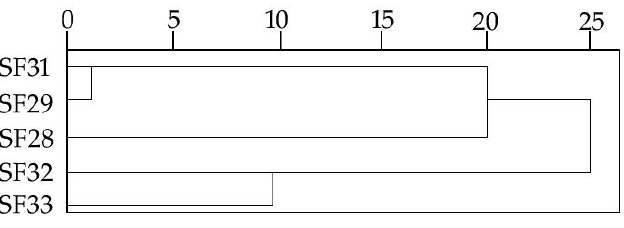
Figure 3. The cluster results of important market-related factors. Table 4. Results of hierarchical cluster analysis (HCA) of the critical factors.